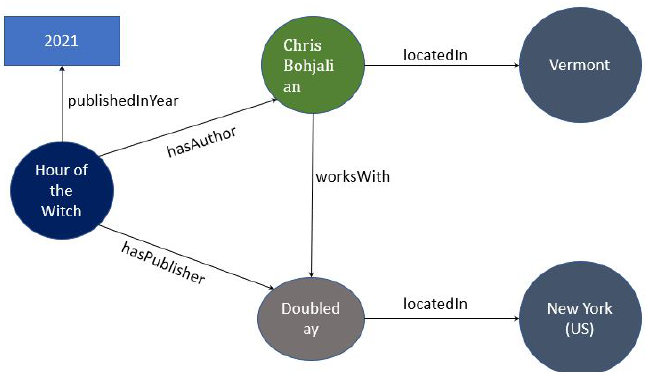
Figure 2. Example of the knowledge graph obtained from the book_ontology (Figure